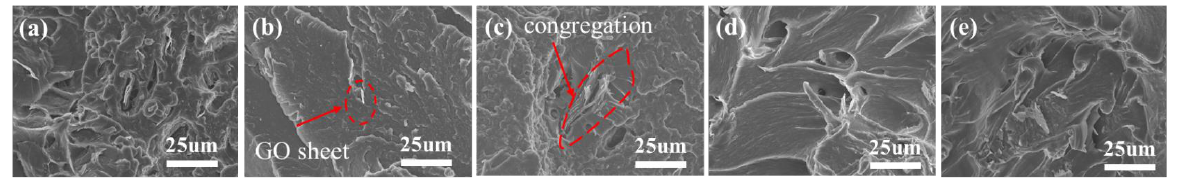
Figure 14. Scanning electron microscopy (SEM) images of tensile section: ( a ) PA10T/1012: ( b ) MPA-1.0 wt% GO: ( c ) MPA-2.0 wt% GO: ( d ) SPA-1.0 wt% GO: ( e ) SPA-2.0 wt% GO.